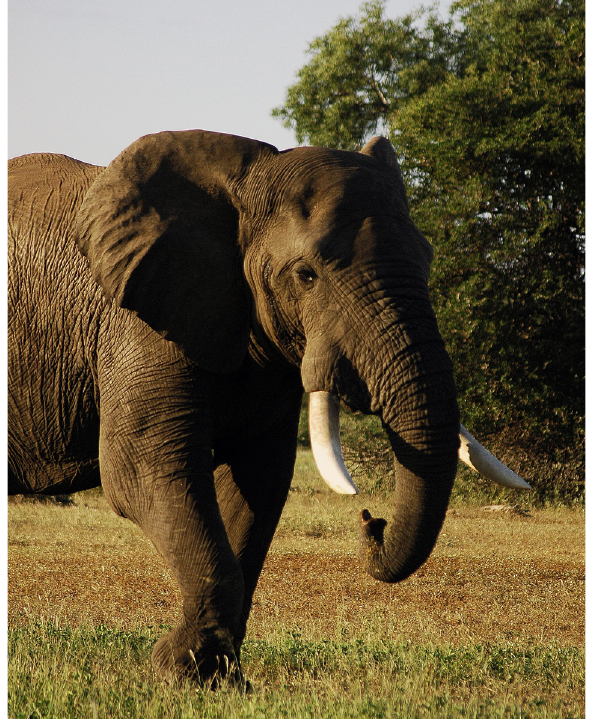
Figure 1: A bull elephant in Ntsiri Nature Reserve adjacent to Kruger National Park, South Africa. This majestic giant needs about 170 kg of green food a day and can be quite destructive in its feeding habits (photo: T.